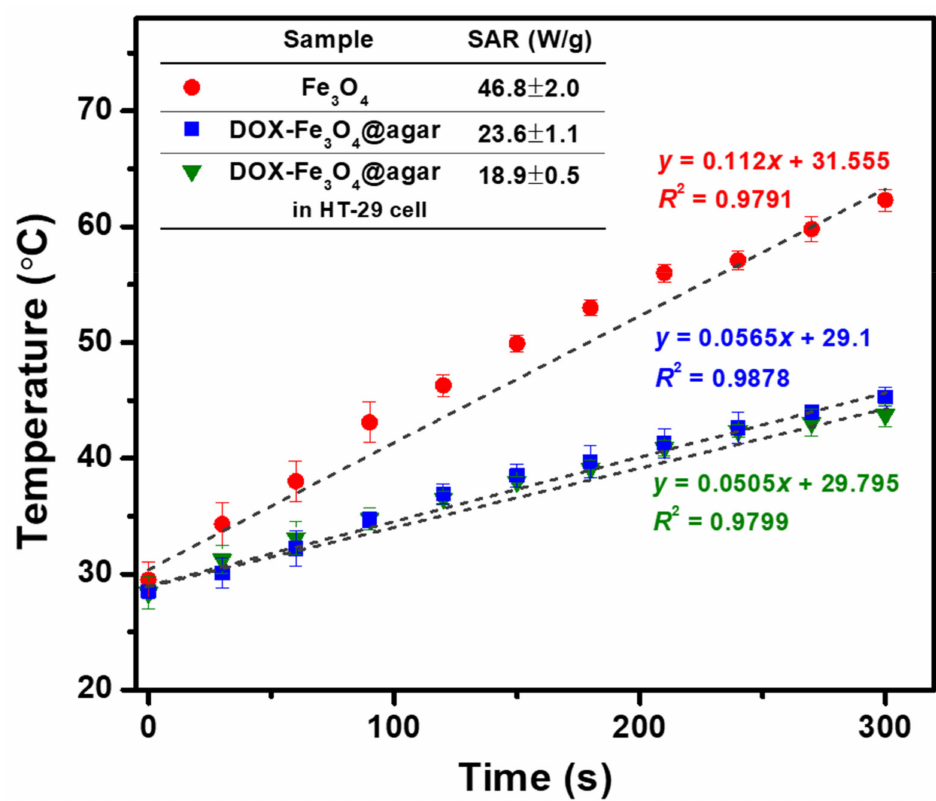
Figure 6. Temperature achieved by Fe 3 O 4 , DOX-Fe 3 O 4 @agar, and DOX-Fe 3 O 4 @agar in HT-29 cells. Here, 5 mg of sample is dispersed in 1 mL of DMEM (applied field = 400 A, f = 250 kHz). Inset shows the SAR values.